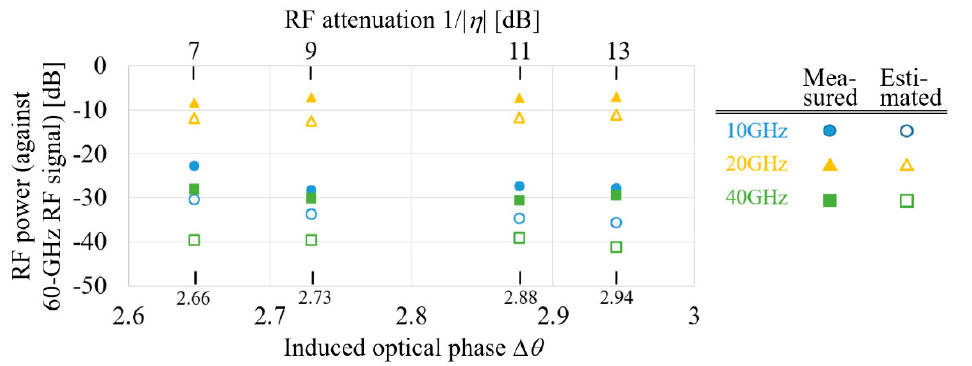
Figure 9. Power ratio of spurs versus the induced optical phase ∆ θ . Origin of the vertical axis corresponds to 60-GHz RF power. Circles, triangles, and squares denote the 10 GHz (1st-order), 20 GHz (2nd-order), and 40 GHz (4th-order) RF signals. The filled symbols indicate experimental results, while the opened symbols indicate results from numerical calculations.